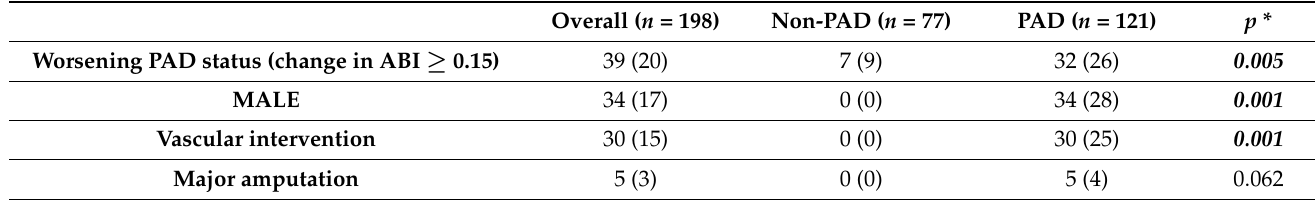
Table 3. Adverse events in patients with and without peripheral artery disease during the 2-year